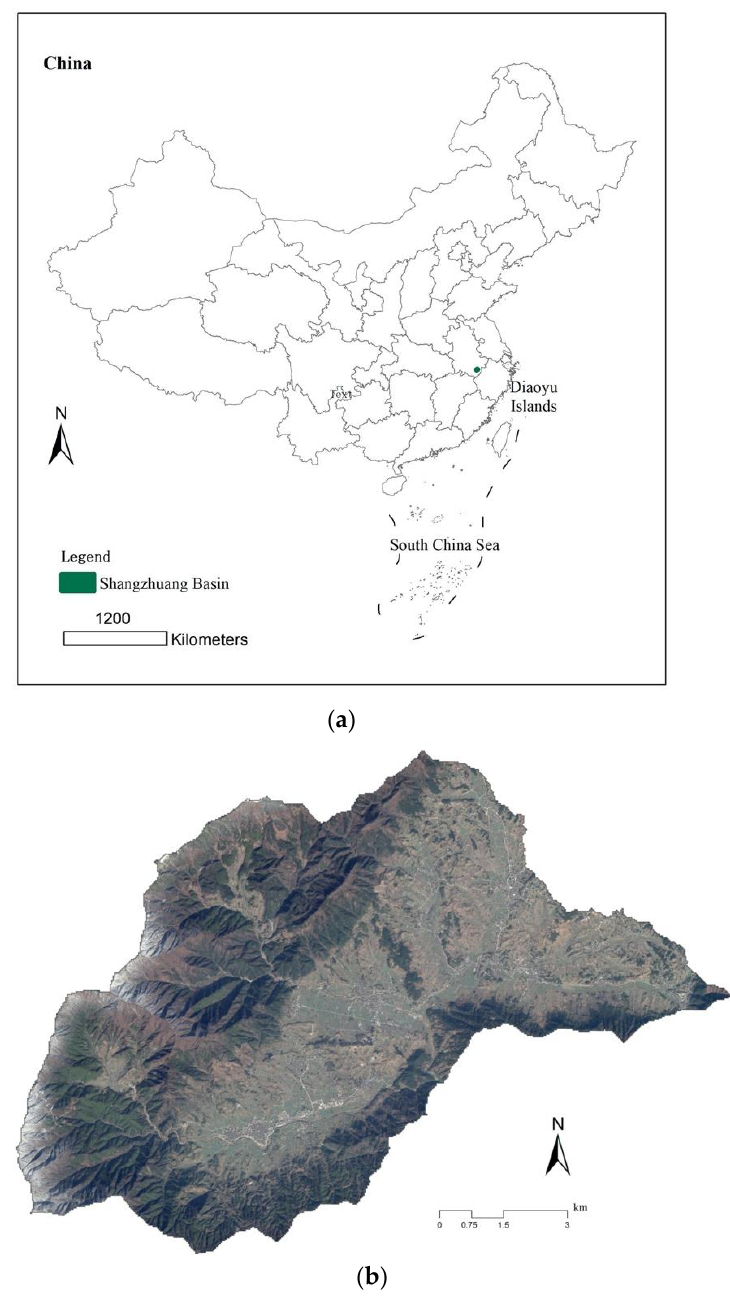
Figure 1. The study area. ( a ) The study area location; ( b ) Shangzhuang Basin.